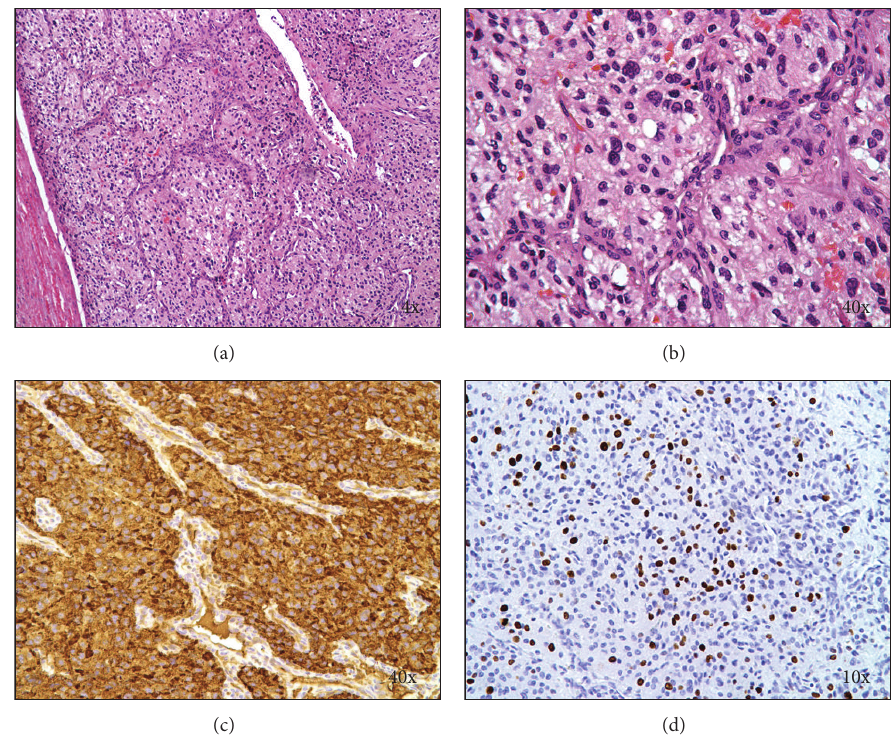
Figure 3: Pathologic images of resected tumor. (a, b) H & E-stained sections of the tumor showing tumor cells with abundant eosinophilic cytoplasm arranged in a nested and trabecular pattern and surrounded by fibrovascular stroma. (c) Chromogranin A staining demonstrating strong positivity of tumor cells. (d) Ki67 (MIB-1) immunostaining confirmed a high proliferation index ( > 10%) of the tumor cell